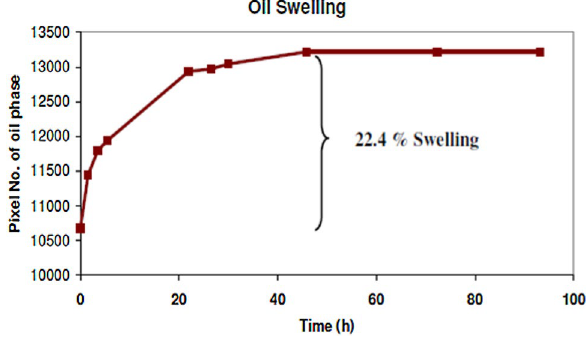
Fig. 5 The oil droplet volume vs time (Sohrabi et al. 2008)